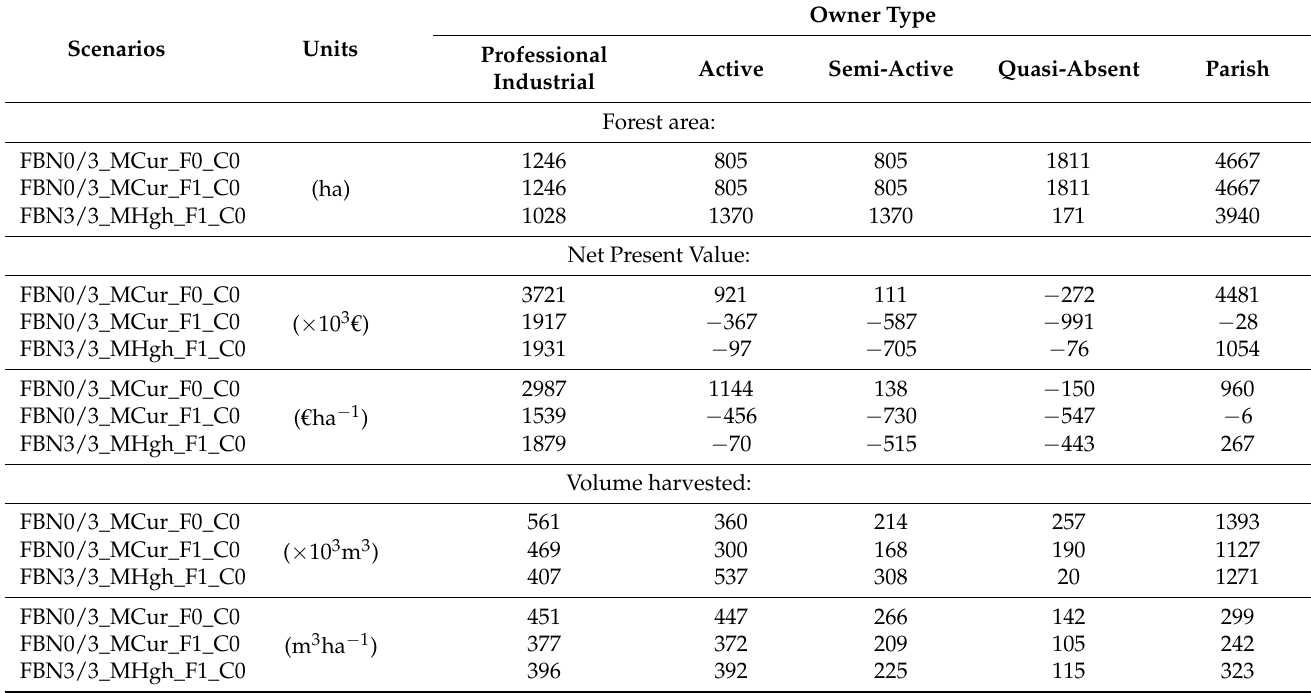
Table 4. Total and per hectare values for NPV and volume harvested by owner type for the BAU (FBN0/3_MCur_F1_C0), the improved management (FBN3/3_MHgh_F1_C0), and the hypothetical no-fire scenario (FBN0/3_MCur_F0_C0).